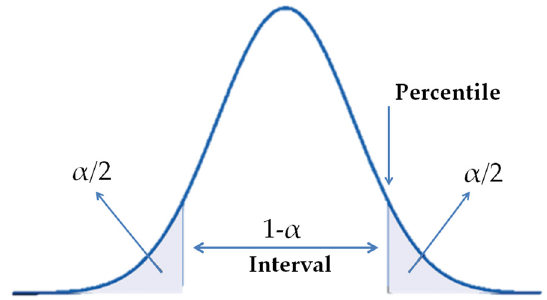
Figure 3. Construct of a CI percentile. Data source: Glen [44]. Values of 90%, 95%, or 99% are generally used as the CL indicator in normal distri- bution, and the corresponding Z distribution (with the difference of several σ ) are 1.65, 1.96, and 2.58, Figure 4.